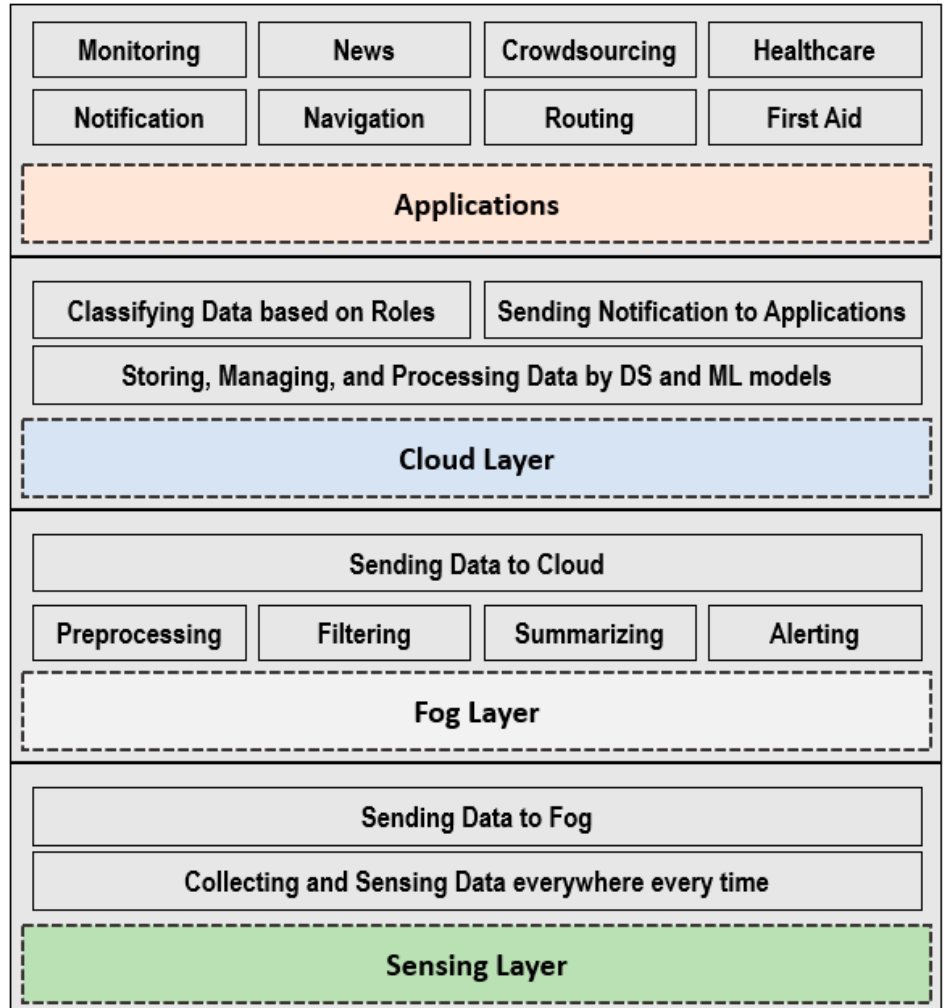
Figure 3. Proposed framework—functional view.